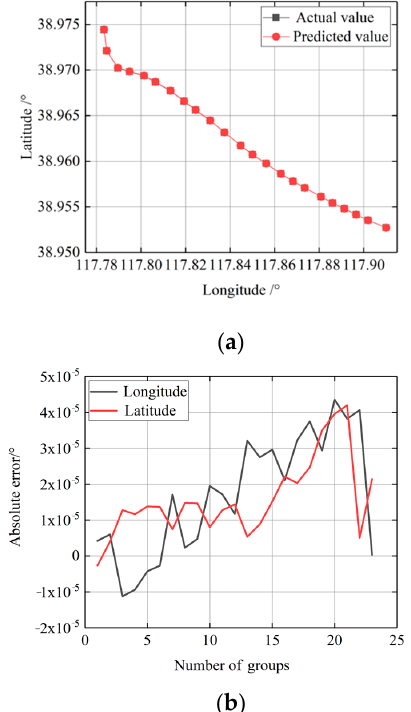
Figure 11. Prediction results of d-trajectory using the ACDE-SVR model. ( a ) Comparison of predicted and actual values of d-trajectory; ( b ) Longitude and latitude absolute error values of